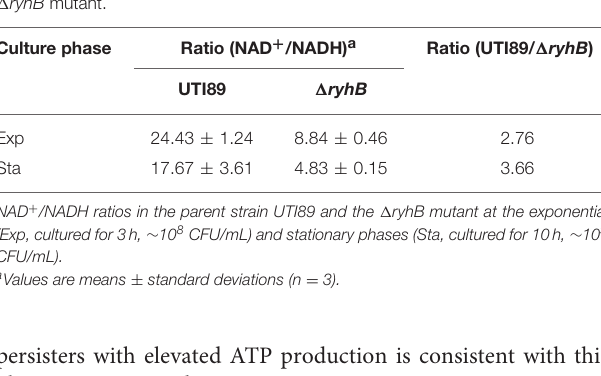
TABLE 2 | Intracellular NAD + /NADH ratios of the parent strain UTI89 and the 1 ryhB